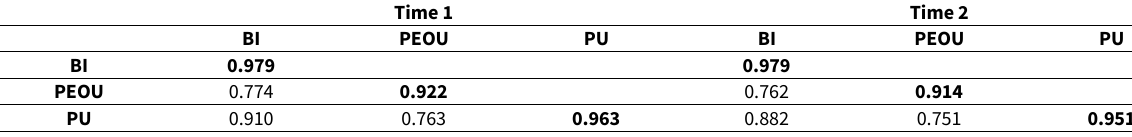
Table 7. Discriminatory validity (Fornell-Larcker criterion)